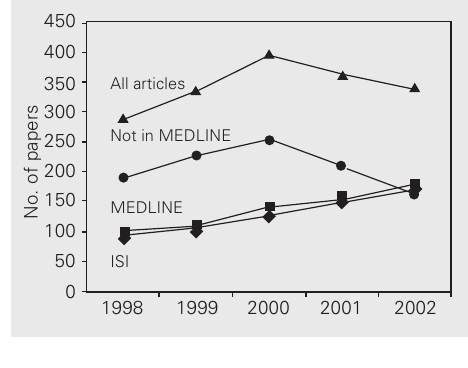
Figure 2. Total number of pub- lished articles in graduate pro- grams in Psychiatry and related areas by year and citation by major indexing services. MEDLINE = The National Li- brary of Medicine; ISI = Insti- tute for Scientific